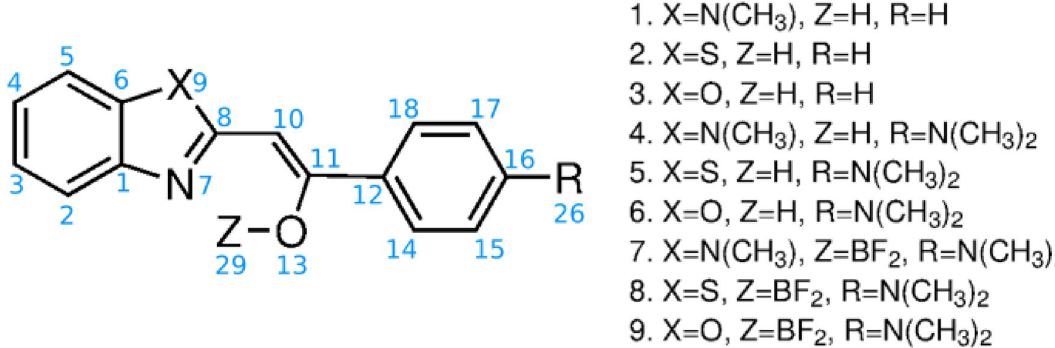
Figure 1. Structures of analyzed compounds (in blue—atom